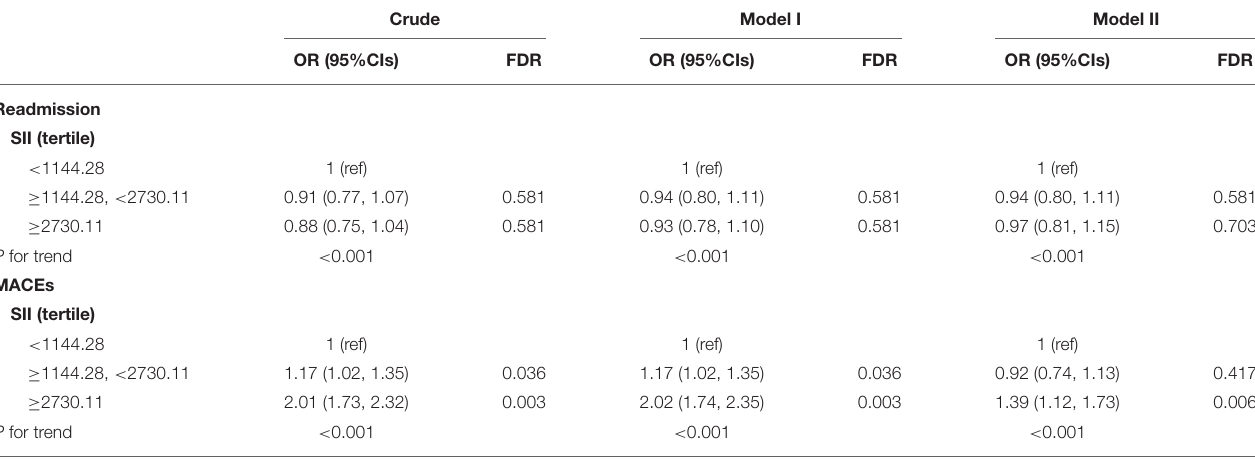
TABLE 3 | The univariate and multivariate Logistic regression analysis exploring the association of SII tertile with readmission and MACEs of critically ill patients with CHF. Crude Model